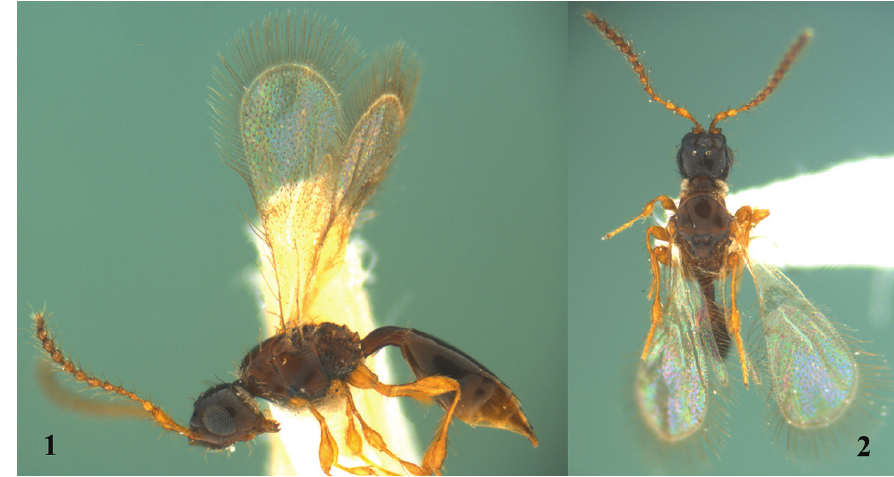
Figures 1–2. Calogalesus sinicus sp. n., ♀ , holotype, habitus. 1 Lateral 2 dorsal.